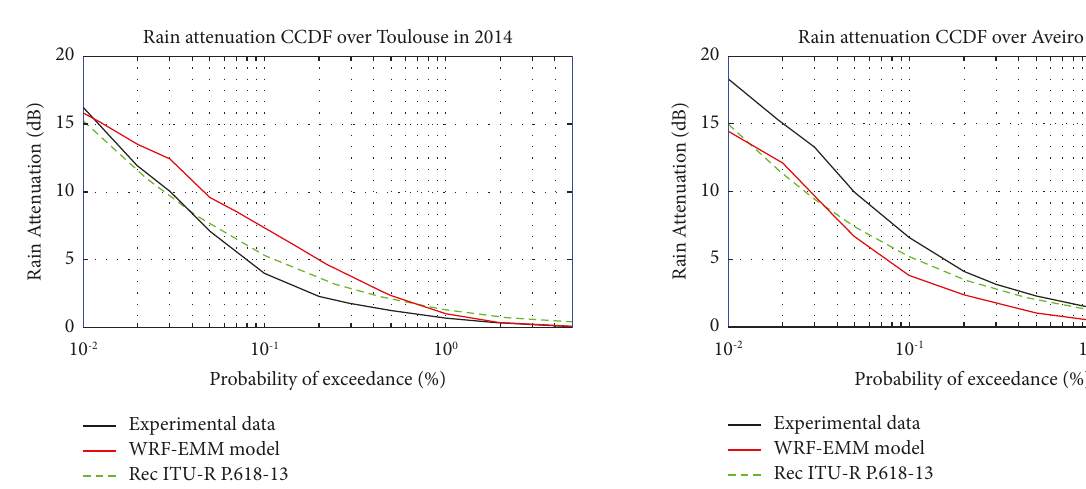
Figure 5: Comparisons between CCDFs computed from mea- surements collected in Toulouse in 2014 (99.2% availability (Fig- ures 5 and 6, the availability refers to the percentage of valid measured attenuation time series over the full measurement pe- riod)), WRF-EMM simulations and Rec. ITU-R P.618–13 using R 0.01 predicted with Rec. ITU-R P.837–7.